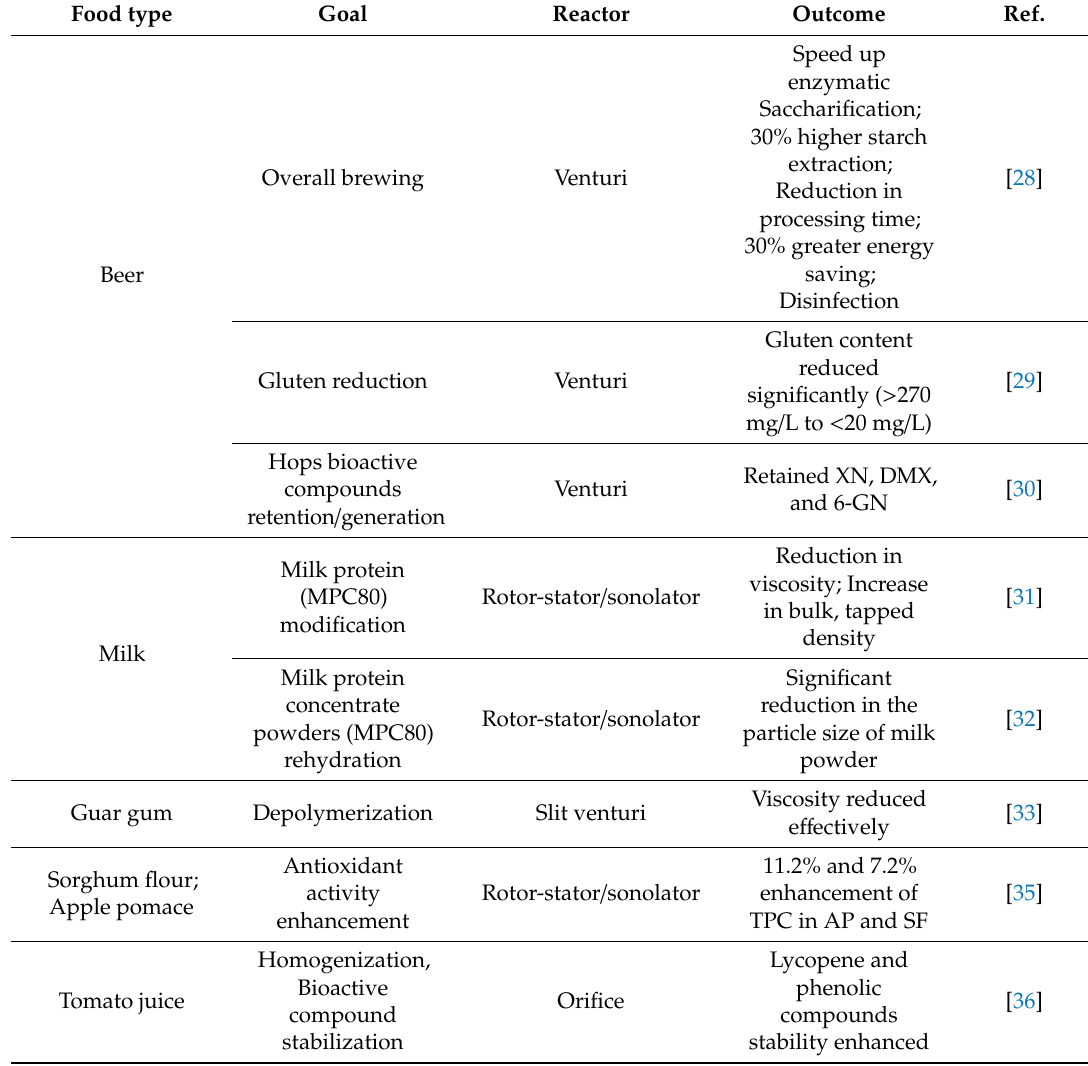
Table 3. Applicability of HC in food